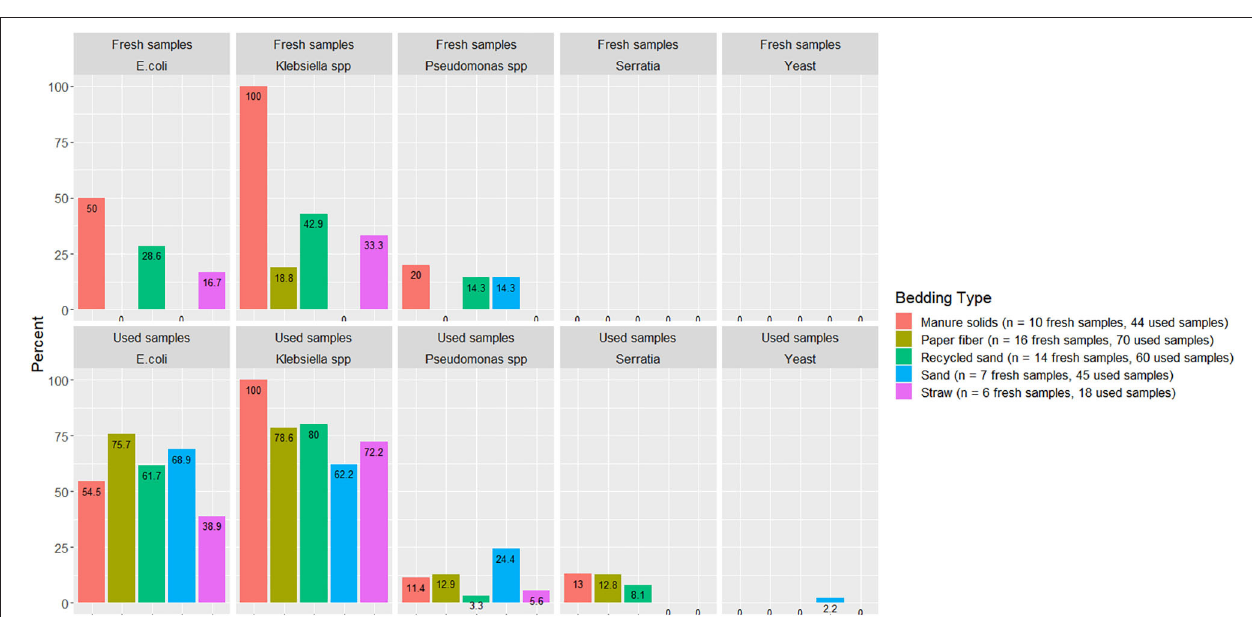
FIGURE 2 | Boxplots showing 25th, 50th (median), and 75th percentiles of the distribution of bacteria counts (log10 CFU/g) for used bedding samples collected from July 2018 to July 2019 from five conveniently selected New York dairy herds using one of five bedding materials in lactating pens. Used bedding samples (three to five) were collected monthly following an SOP at each visit (unless there was no bedding available due to lack of supply or equipment malfunction on the follow-up visit).